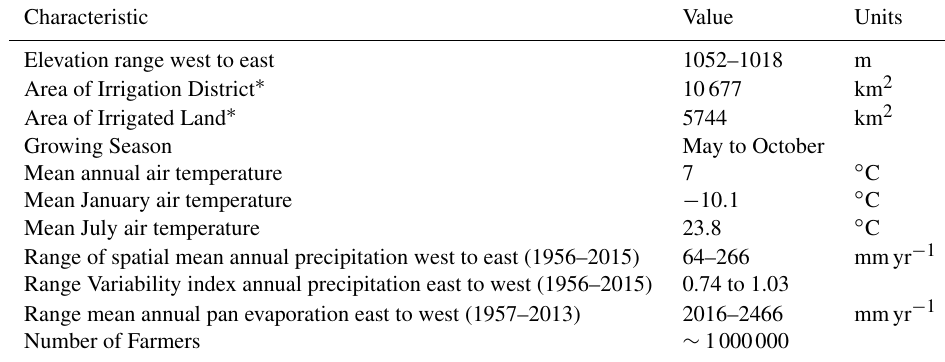
Table 1. Characteristics of the Hetao Irrigation District.